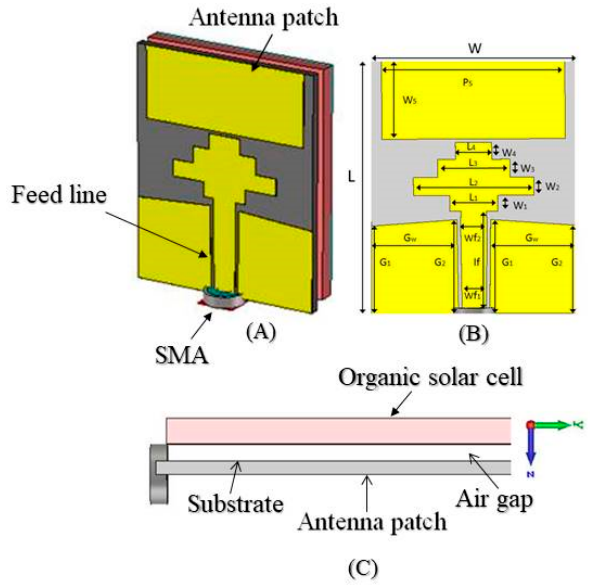
Figure 1. ( A ) The prototype CPW antenna design; ( B ) front view dimensions; and ( C ) side view of the organic solar cell (OSC) integrated antenna.